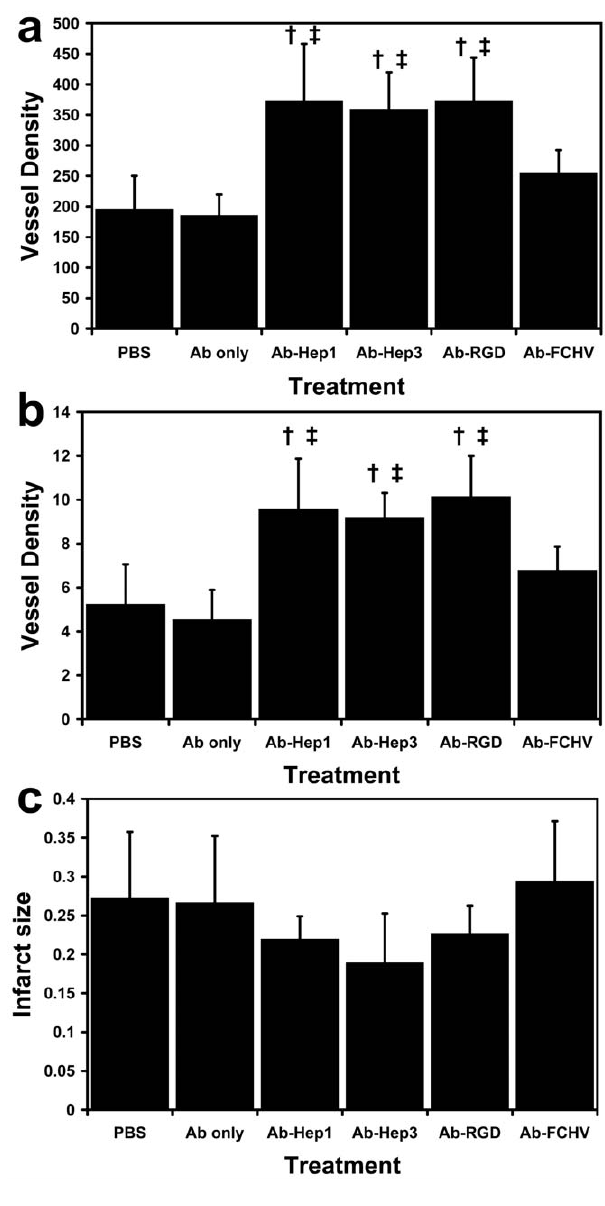
Figure 3. Increased neovascularization within the MI region. ( a ) Capillary staining showed significantly higher capillary density for rats treated with Ab-HepI, Ab-HepIII, or Ab-RGD. { P , 0.05 vs. PBS, { P , 0.05 vs. Ab-FC/HV. ( b ) Arteriole staining also showed significantly higher arteriole density for rats treated with Ab-HepI, Ab-HepIII, or Ab-RGD. { P , 0.05 vs. PBS, { P , 0.05 vs. Ab-FC/HV. ( c ) Infarct size measurements showed no statistically significant differences between the treatment groups and the PBS treatment